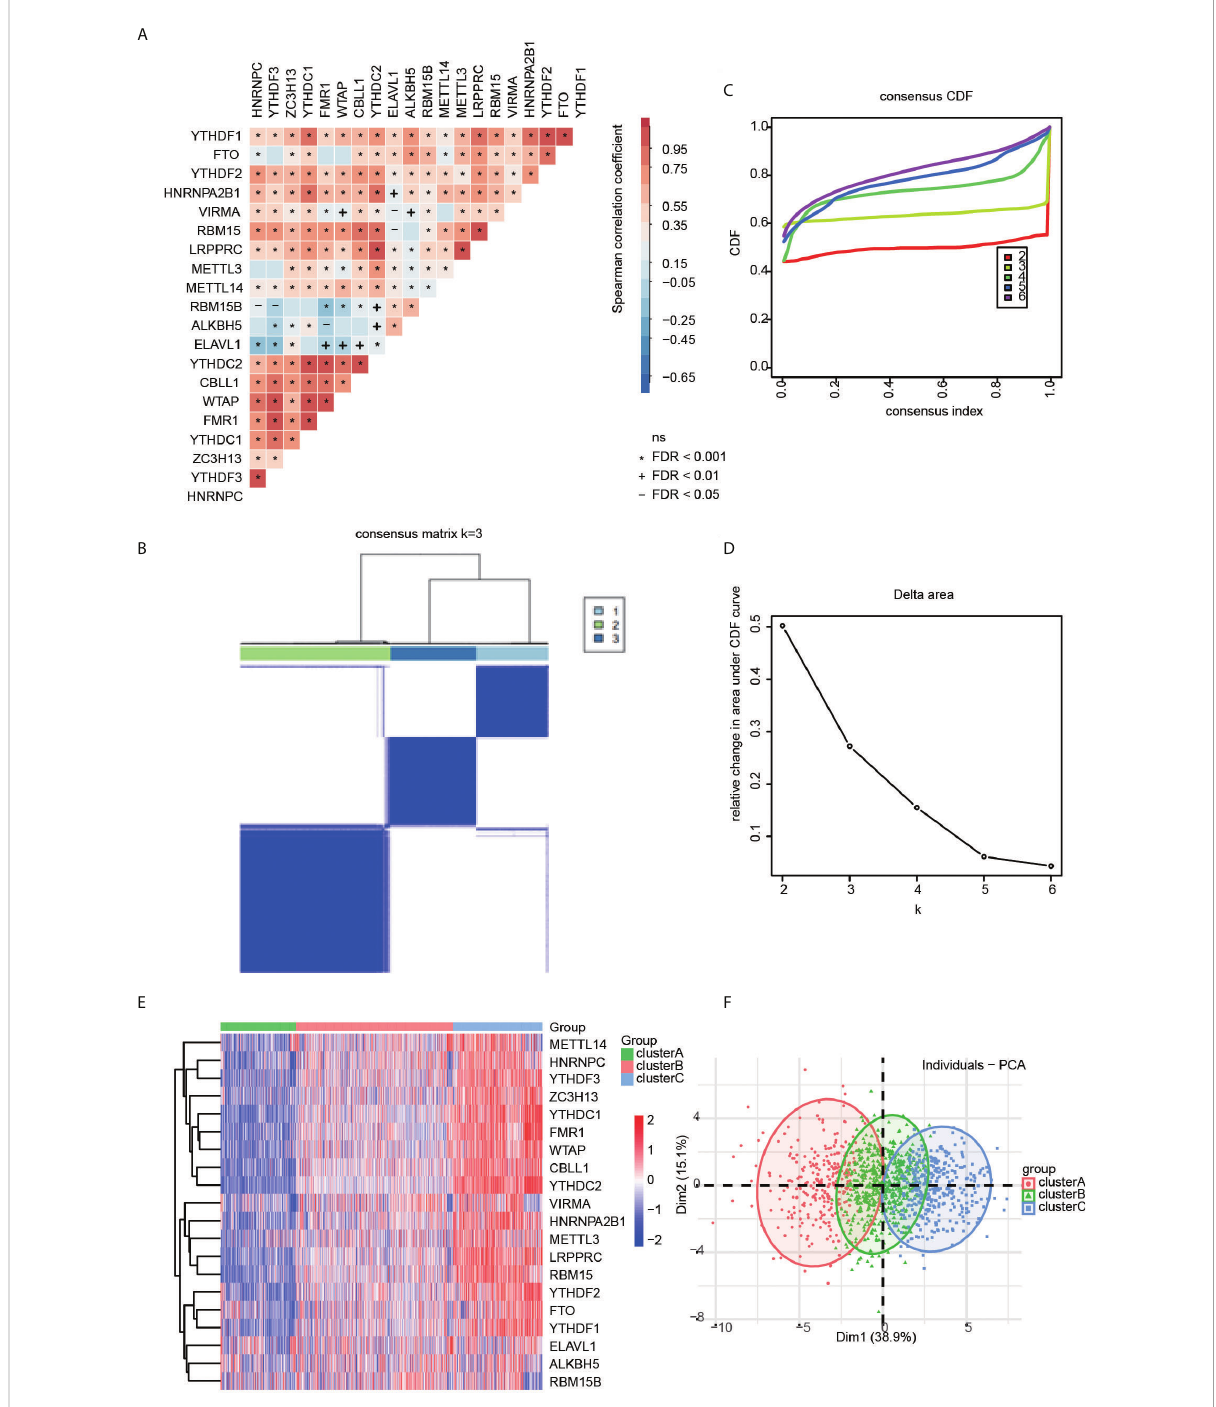
FIGURE 2 (A) Correlation heatmap for all 20 m6a regulators in RA patients. Some regulators were negatively related, represented in blue, and others were positively correlated, represented in red. The darker the color, the higher the correlation. (B) The consensus cluster matrix for k = 3 shows three major clusters. (C) Consensus clustering cumulative distribution function (CDF) for k = 2 – 6, which can completely describe the probability distribution of a real random variable. (D) The relative change of CDF Delta area curve for k = 2 – 6. (E) The distribution of 20 m6A RNA methylation regulators among three clusters. (F) Visualization of the clustering results through a scheme based on principal component analysis